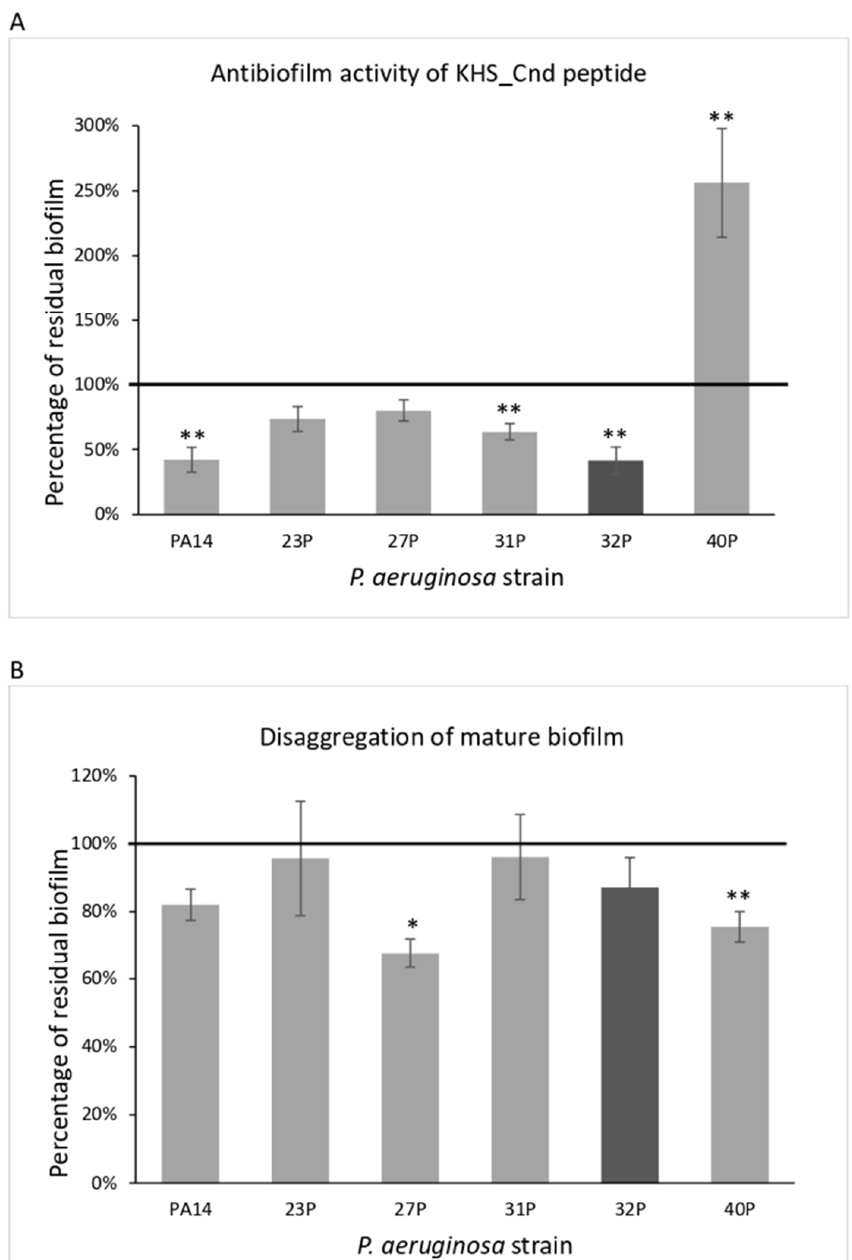
Figure 1. Effect of KHS-Cnd on biofilm formation by different clinical strains and the PA14 reference strain. Panel ( A ): Effect of KHS-Cnd on biofilm formation. KHS-Cnd was added to the culture medium at time zero (0 h, pre-adhesion period) and the biofilm was analyzed after overnight incubation. In the ordinate axis, the percentage of bacterial biofilm production is reported. Data are expressed as the percentage of biofilm formed in the presence of 40 µM KHS-Cnd (except for 32P where 20 µM KHS-Cnd was used) compared with the untreated bacteria. Each data point is composed of three independent experiments, each performed at least in three replicates. Panel ( B ): Effect of KHS-Cnd on the mature biofilm. KHS-Cnd was added to the culture medium after 24 h of biofilm growth (24 h of bacterial culture) and the biofilm was analyzed after overnight incubation. In the ordinate axis, the percentage of residual biofilm is reported. Data are expressed as the percentage of residual biofilm after 24 h of treatment with 40 µM KHS-Cnd (except for 32P where 20 µM KHS-Cnd was used) compared with the control sample. Error bars indicate the standard deviations of all of the measurements. Statistical difference was determined by the Student’s t -test: * p < 0.05; ** p < 0.01, compared with the control.